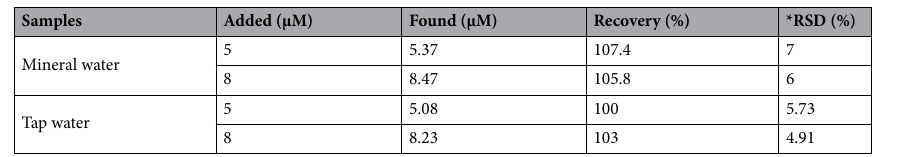
Table 3. Recovery percentages and errors obtained after the determination of phenol in tap and mineral water samples. *n = 3.